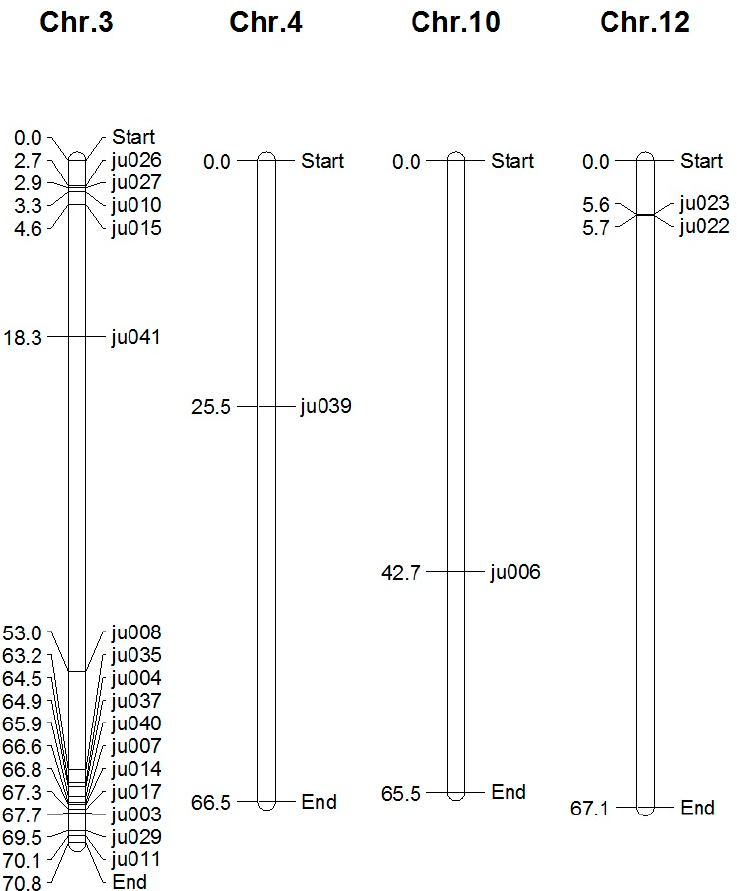
Figure 1. Distribution of novel microsatellite loci in different tomato chromosomes. Loci (right to chromosome) and their corresponding distance in Mb (left to chromosome).